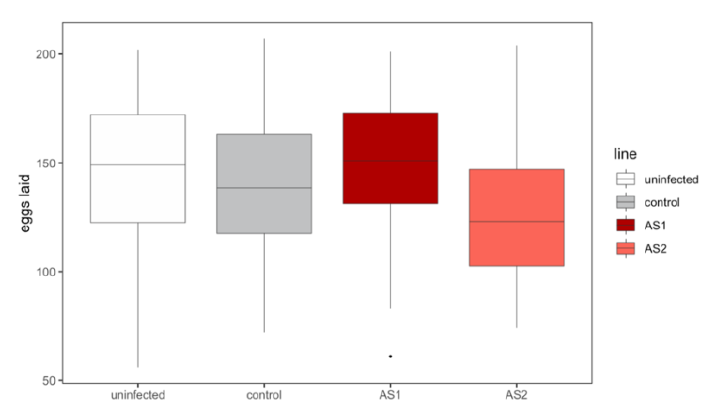
Figure 4: Experiment 2. Fecundity of Culex pipiens females uninfected (n=60) or infected with each of the different parasite lines (n=60 per line). The number of eggs per raft is represented as a boxplot with the median (horizontal lines), first and third quartiles (box above and below the medians). Vertical lines delimit 1.5 times the inter-quartile range above which individual counts are considered outliers and marked as circles.